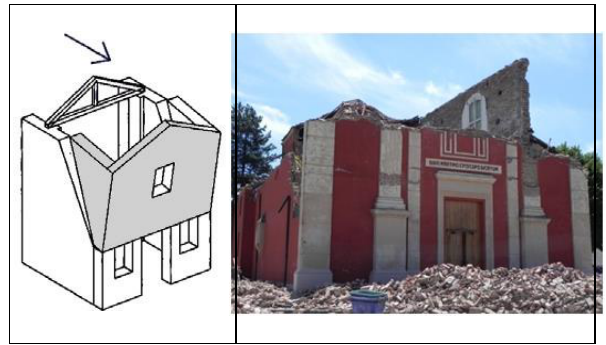
Figure 1. The evidence of “local mechanism” during an earthquake: on the left, the mechanism of façade turning, and on the right the evidence of this mechanism after the strong Emilia Romagna earthquake (May